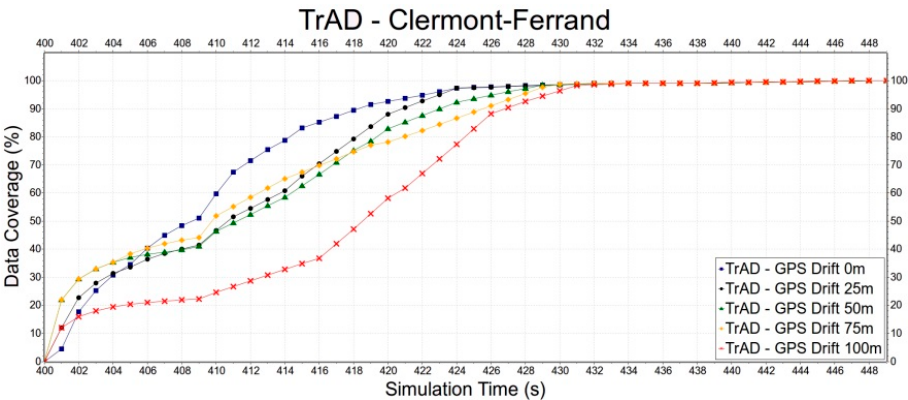
Figure 14. The impact of GPS drift on TrAD in Clermont-Ferrand scenario.